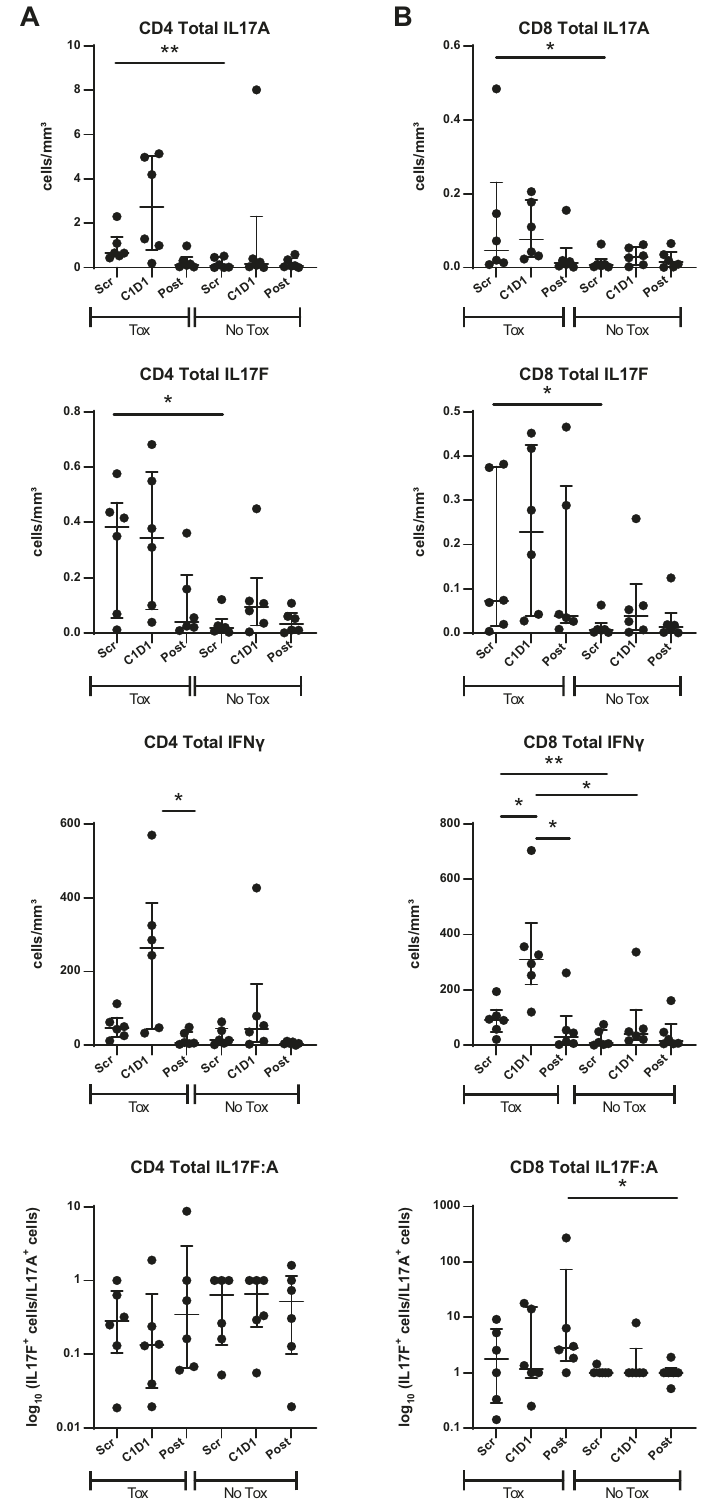
Fig. 4 Intracellular fl ow cytometry measurements of IL-17A, IL-17F and IFN γ in CD4 and CD8 T cells treated with duvelisib. A Absolute number of CD4 T cells positive for the indicated cytokine at Scr (screen timepoint), C1D1 (7 days on duvelisib prior to FCR) and either 2 or 6 months post FCR, comparing patients with early toxicity (Tox) to either delayed or no toxicity (No Tox). The bottom panel is the ratio of IL17F:A. B Absolute number of CD8 T cells positive for the indicated cytokine at Scr (screen timepoint), C1 (7 days on duvelisib prior to FCR) and either 2 or 6 months post FCR, comparing patients with early toxicity (Tox) to either delayed or no toxicity (No Tox). The bottom panel is the ratio of IL17F:A. * p ≤ 0.05; ** p ≤